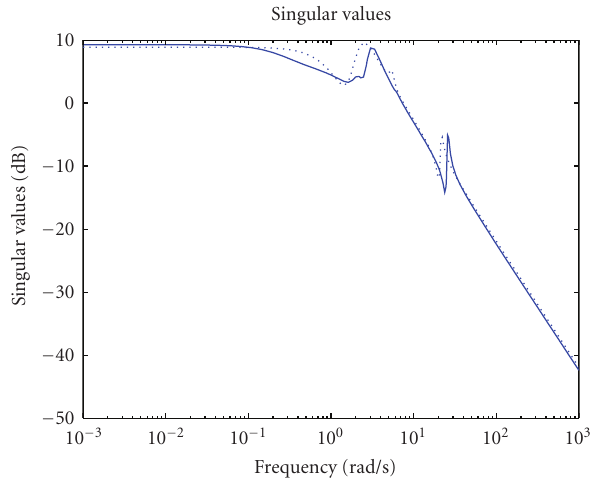
Figure 10: The infinity norm of original of transfer matrix of first subsystem (solid line) and its reduced-order counterpart of order 19 (dotted) over frequency domain [ ω 1 , ω 2 ] = [0 . 001,1000].